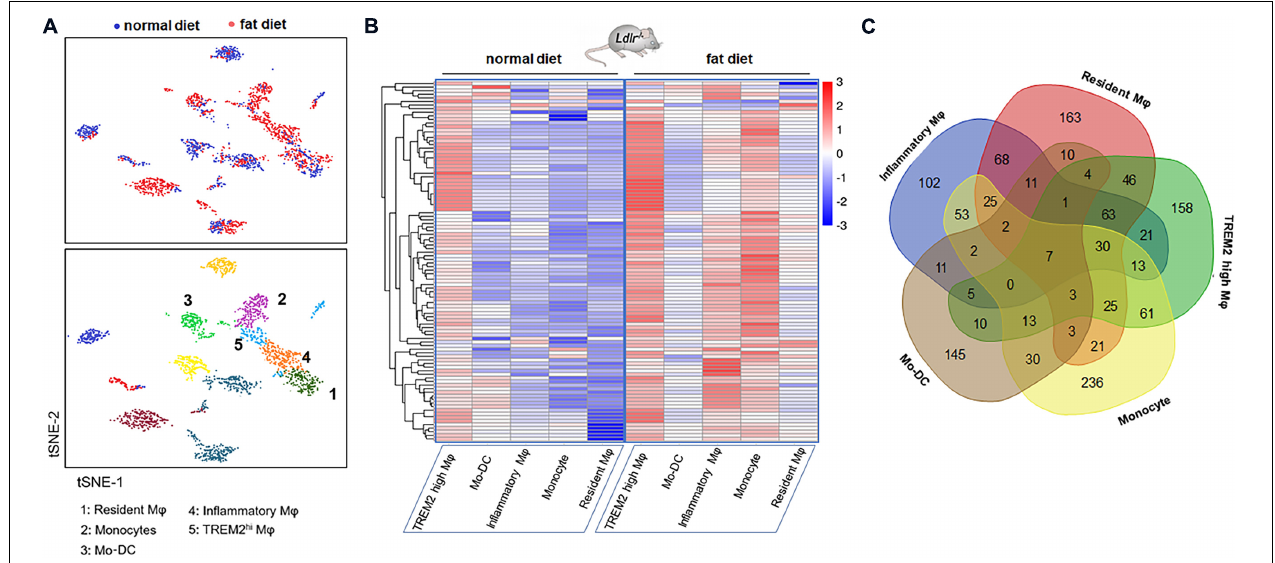
FIGURE 1 | Gene expression signature of macrophages in the atherosclerotic aorta. (A) Five monocyte-related populations in atherosclerotic aortas from Ldlr − / − mice fed with a high-fat diet by single-cell RNA-seq, followed with tSNE analysis (data from Clement et al.). (B) Heatmap of differentially expressed genes in five clusters. Genes were ordered by hierarchical clustering. (C) Venn diagram of the gene characteristics of the five clusters.